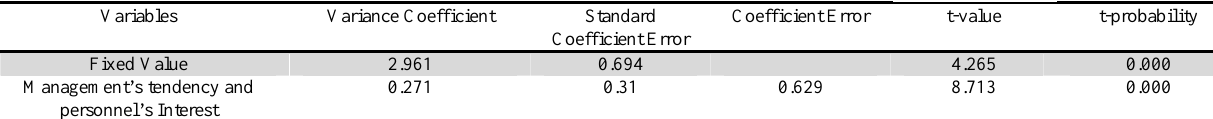
Regression Coefficients and T-Test